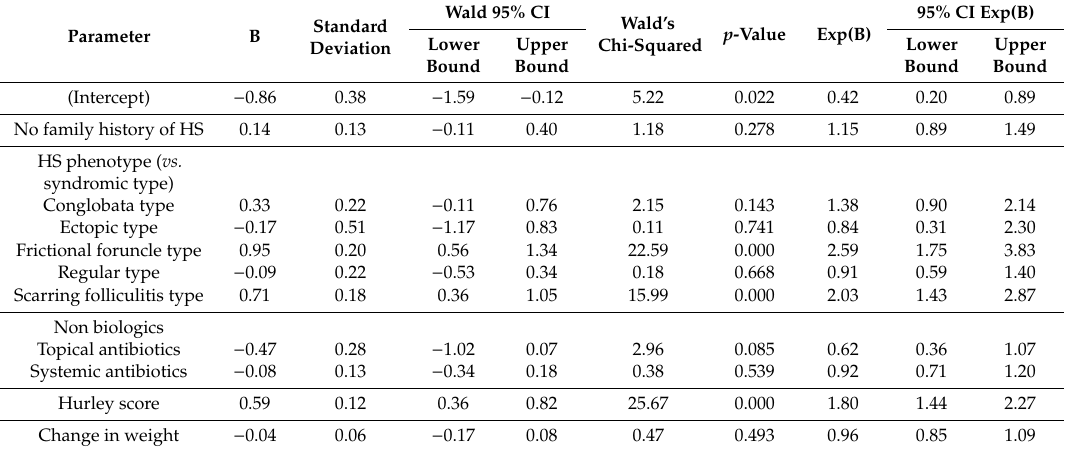
Table 3. Multivariate log-linear robust Poisson regression analysis shedding light on the determinants of change in abscesses before, during and after the month of Ramadan.